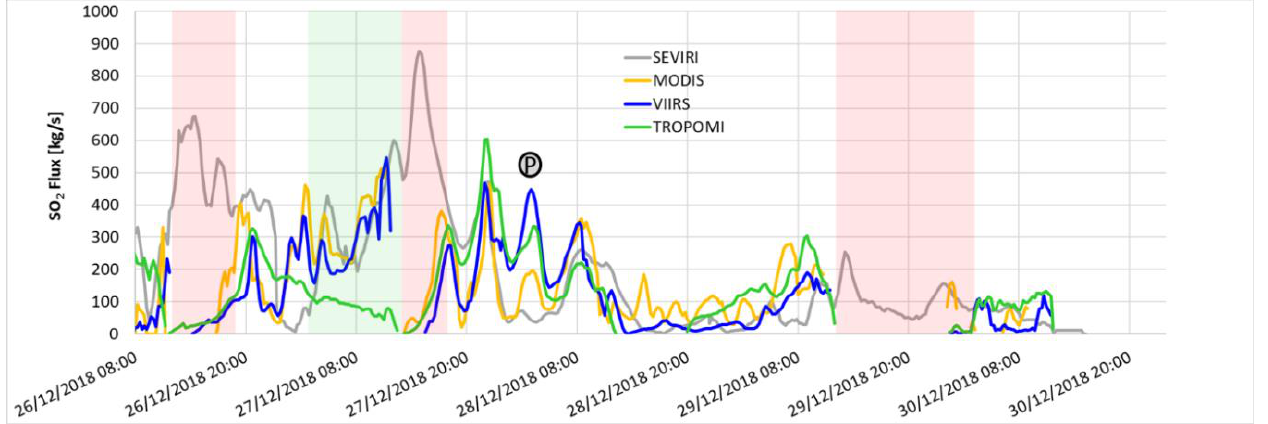
Figure 9. SO 2 fluxes obtained from SEVIRI, MODIS, VIIRS and TROPOMI measurements. The colored rectangle areas indicate the regions where the GEO and LEO retrieval discrepancies are significant. Light red areas: differences due to LEO images not available and/or where the plume dilution of the distal part of the cloud is significant. Light green area: differences due to the presence of volcanic ash. Point “P” is an example of an SO 2 peak not detected from SEVIRI.